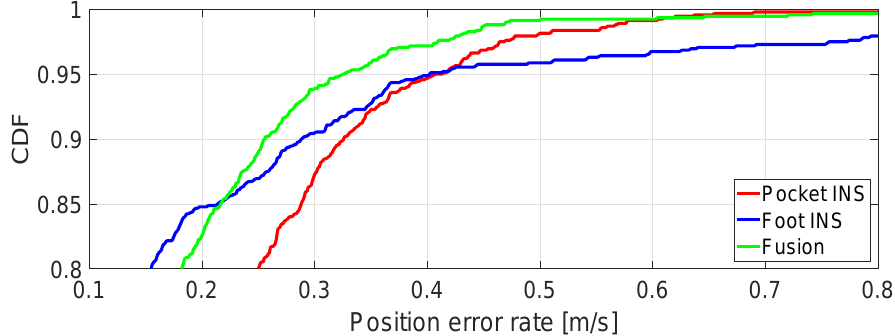
Figure 13. Cumulative distribution function (CDF) of the position error rate.